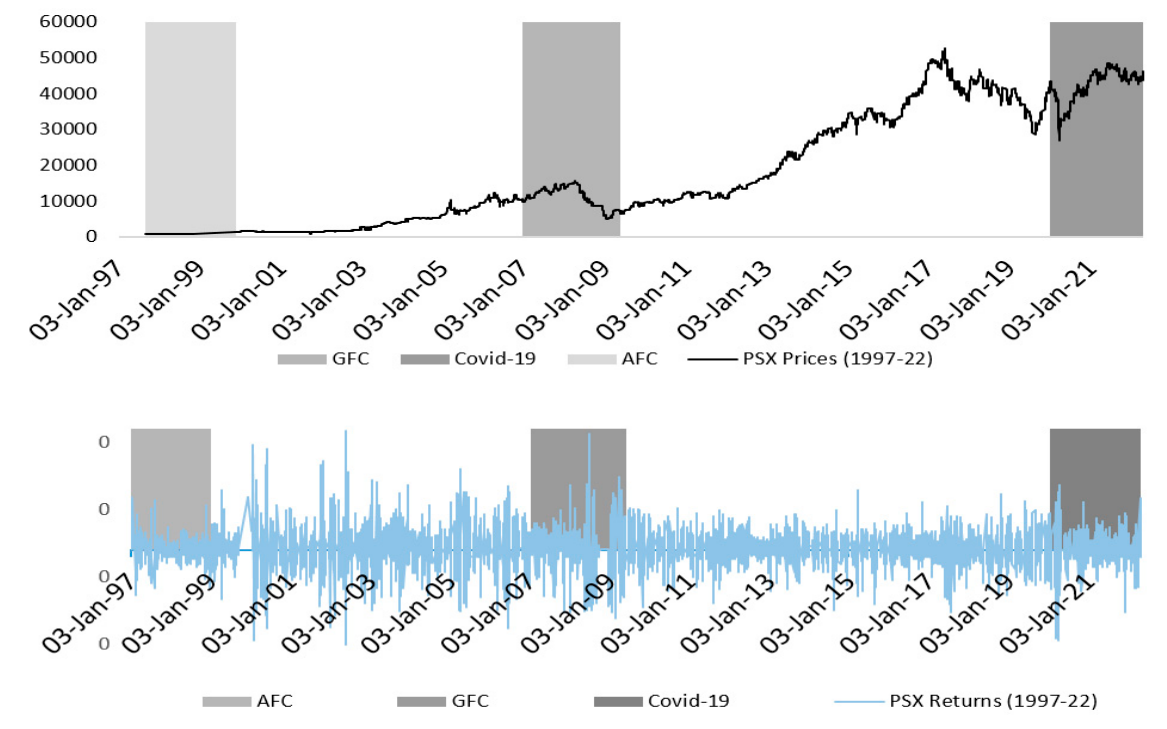
Figure 1. Stock Prices and Returns for the Period of 1995–2022. Error! Reference source not found.